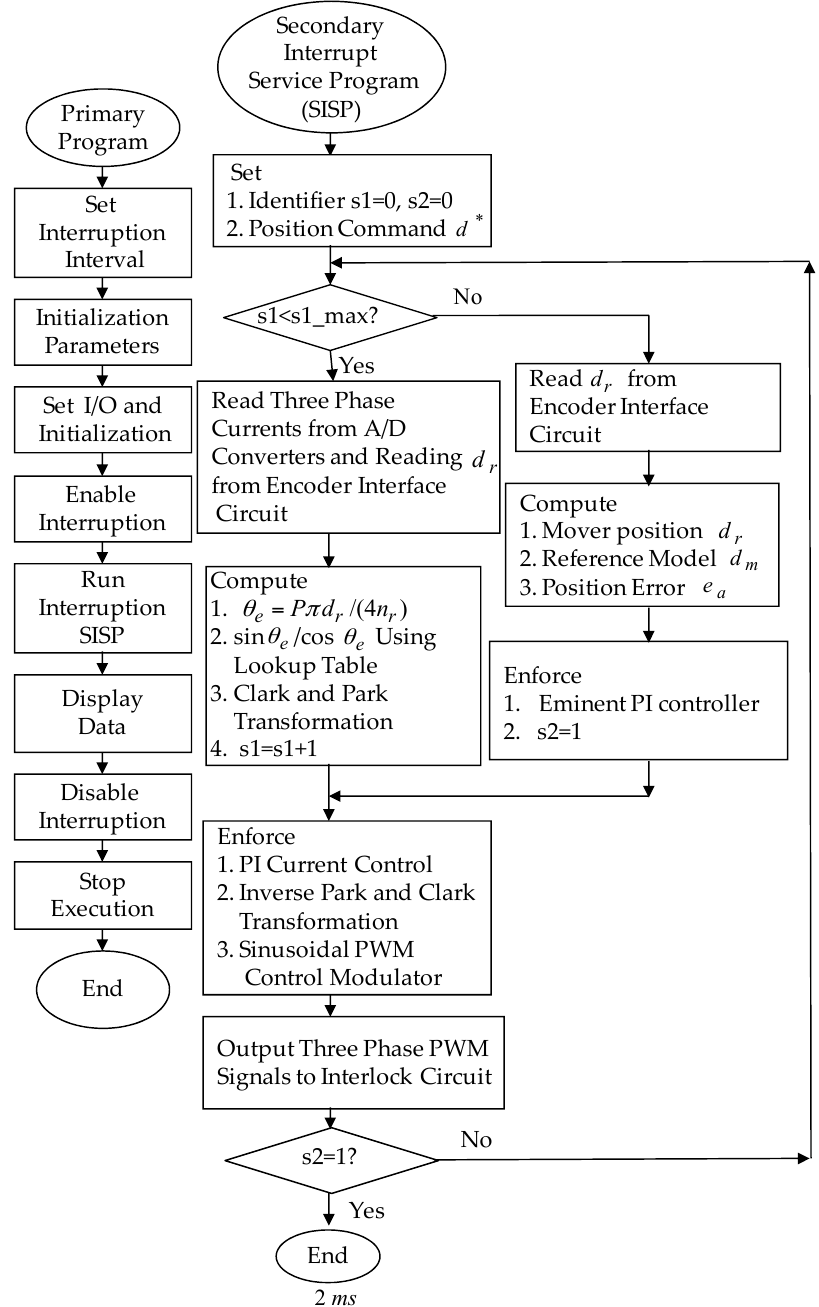
Figure 8. Flowchart of the enforced eminent PI controller program by use of the DSP control system.